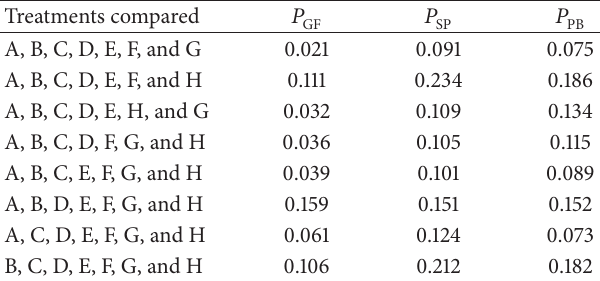
Table 4: 𝑃 values in Section